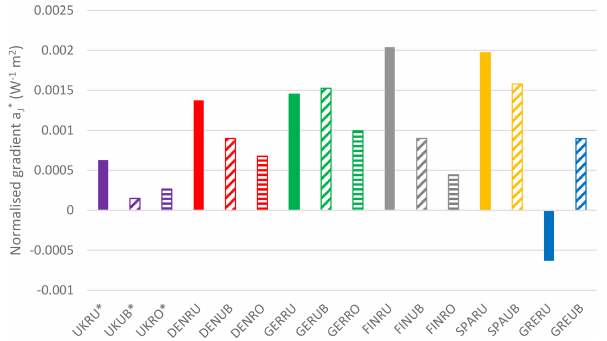
for K ↓ (*UK sites are calcu- J